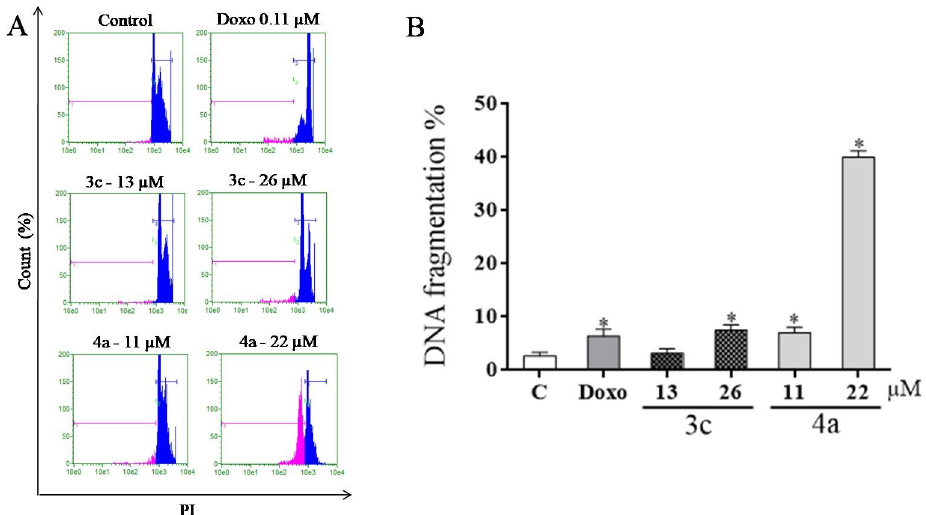
Figure 7. E ff ect of compounds 3c and 4a on DNA fragmentation of HL-60 cells after 72 h of incubation. ( A ) Apoptotic cells with fragmented DNA (pink color) are identified as the sub-G1 population, seen to the left of the G1 peak (blue color). ( B ) Histograms indicating the percentage of cells with DNA fragmentation. Doxorubicin (Doxo, 0.11 µ M) was used as standard. C = negative control treated with the vehicle (DMSO; 0.1%). Results are expressed as mean ± SD of at least three di ff erent experiments performed in triplicate. * p < 0.05 compared with the negative control by ANOVA followed by Student Newman-Keuls test.